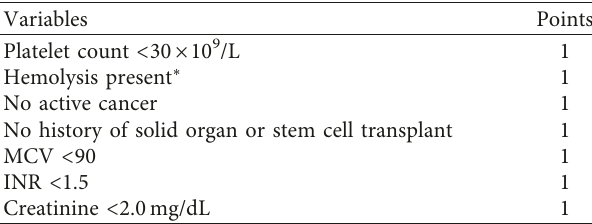
Table 1: PLASMIC scoring system.